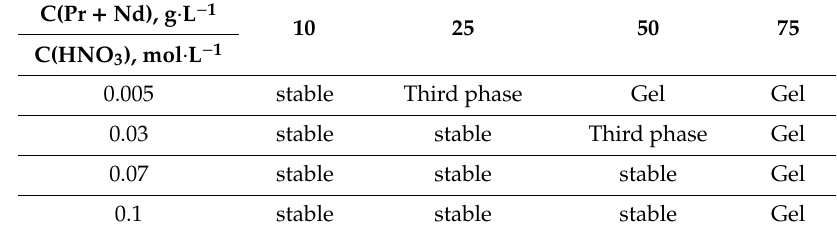
Table 1. Third phase formation in systems containing nitric acid and didymium. Organic phase — 1